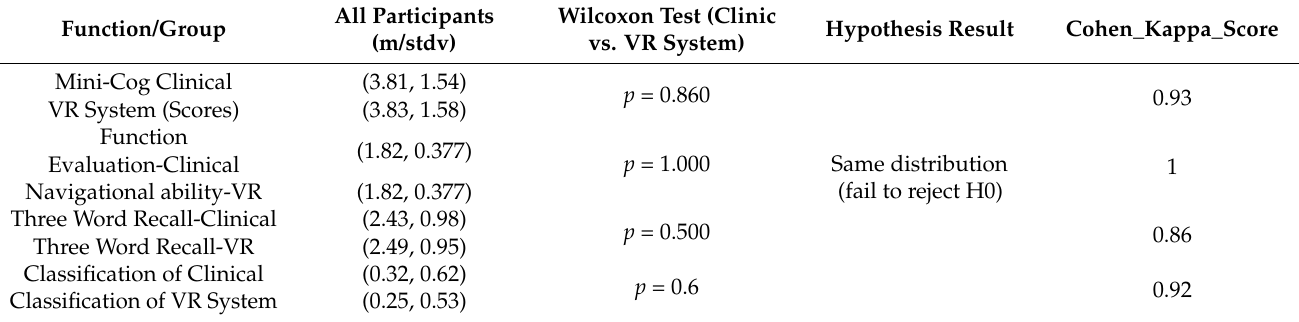
Table 3. Wilcoxon test and Cohen kappa of cognitive test in both clinic vs. VR